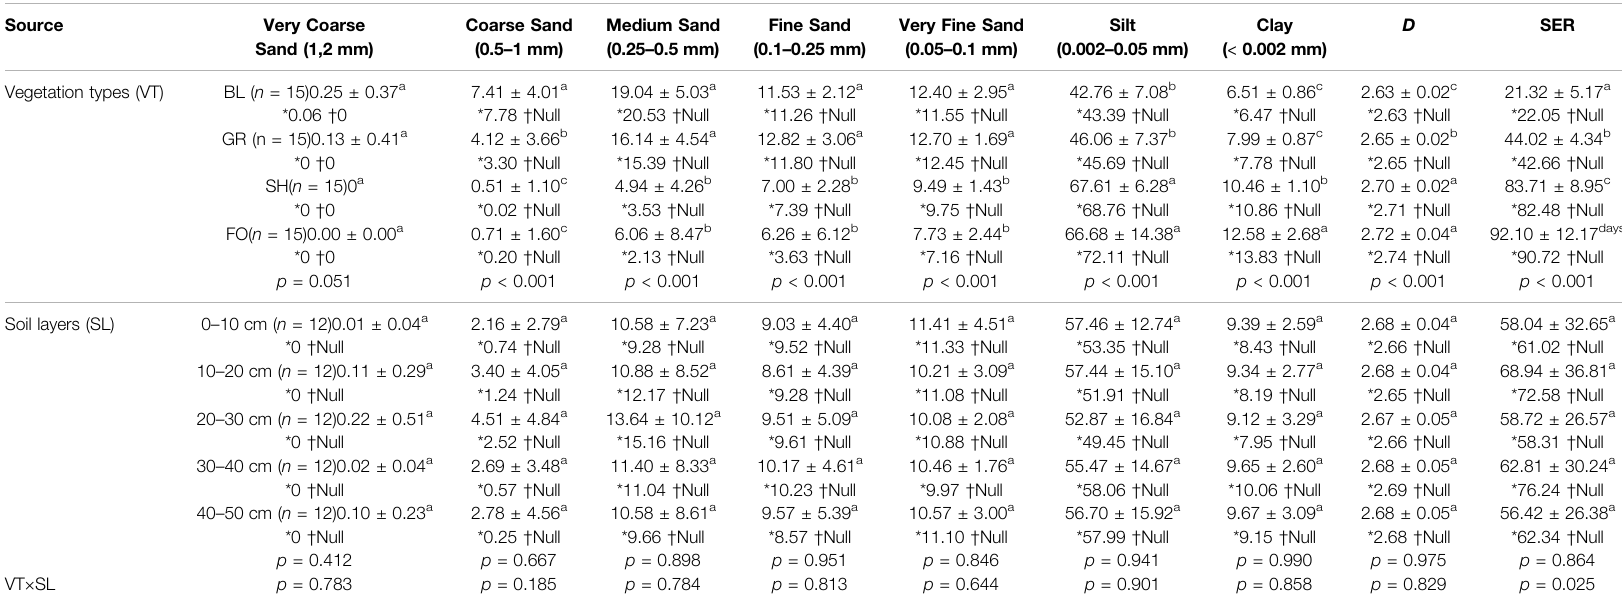
TABLE2| Soilparticlesizedistributionandsingularfractaldimension amongfourvegetationtypesand fi vesoillayers.BL:Bareland;GR:Grassland;SH:Shrub;FO:Forest; D :volumetricfractaldimension; SER:Soilerosion resistance; Different letters indicate signi fi cant differences at p < 0.05. All data are shown using mean ± standard error. * means median; † means mode. Source